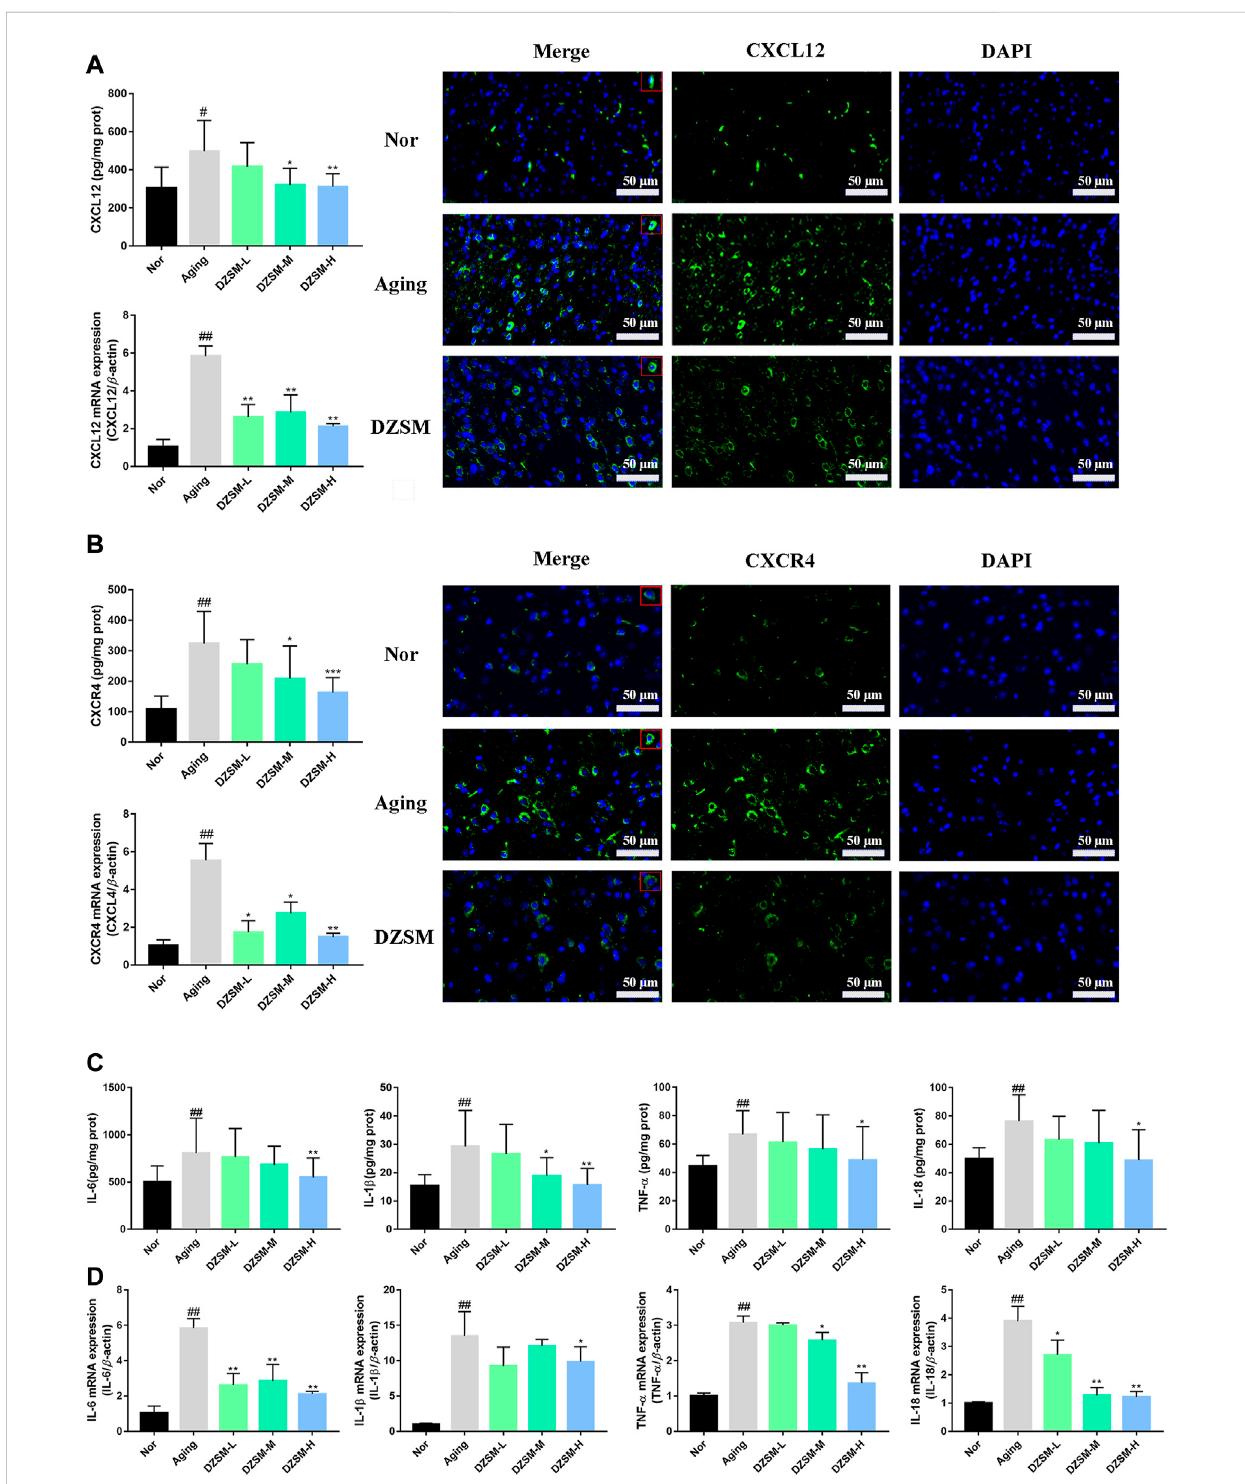
FIGURE 5 DZSMdownregulatedCXCR4 andCXCR12expression andinhibited in fl ammatorycytokine production. (A) RT-PCR, ELISA, andIFanalysis ofCXCR4 (Bar length: 50 μ m); (B) RT-PCR, ELISA, and IF analysis of CXCL12 (Bar length: 50 μ m); (C) Analysis of IL-1 β , IL-6, TNF- α , and IL-18 levels by ELISA. (D) RT- PCR analysis ofIL-1 β , IL-6, TNF- α , and IL-18 (comparedwith the Nor group: # p < 0.05, ## p < 0.01; compared with the Aging group: * p < 0.05, ** p <